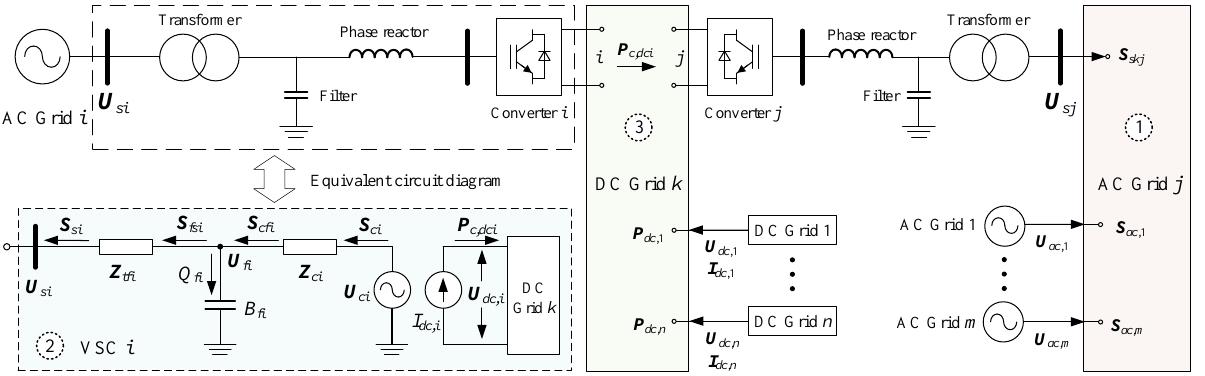
Figure 1. Equivalent diagram of power exchange process in AC/DC hybrid power grid. Numbers 1 to 3 represent the internal structure equivalent diagram of the AC power grid, converter station, and DC power grid, respectively.